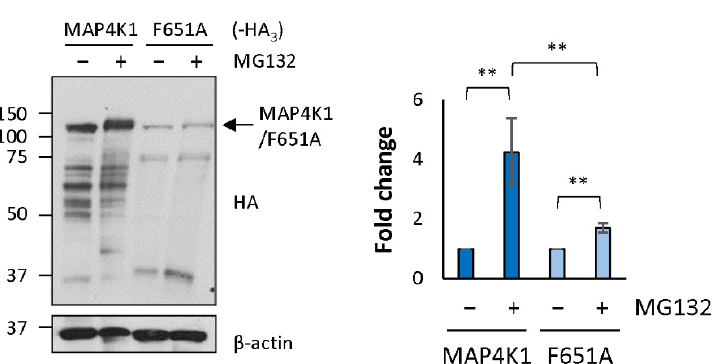
Figure 4. MAP4K1 is degraded via the conserved degradation motif. HEK293T cells were transfected with plasmids coding for MAP4K1-HA 3 or MAP4K1 F651A -HA 3 (F651A) and, 24 h later, treated with the proteasome inhibitor MG132 for 8 h (+). Protein extracts were analyzed by Western blotting using anti-HA antibody. The graph on the right represents the means ± standard deviation of the relative amounts of the proteins in three independently performed experiments. The ratio of the amount of MAP4K1-HA 3 and MAP4K1 F651A -HA 3 to that of actin in the absence ( − ) of MG132 was fixed to 1. **, p -value ≤ 0.01 (Student t